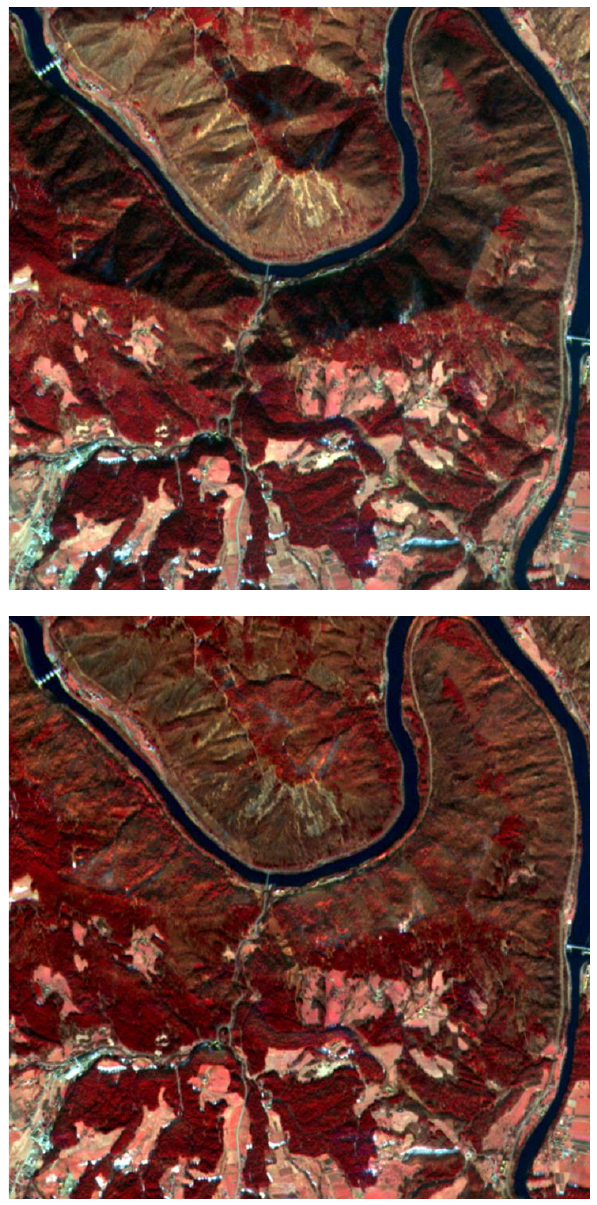
Figure 12. Comparison between false-colour composite image before (above) and after (below) the automatic topographic corrections (detail). On the corrected image the influence of topography is extensively reduced.